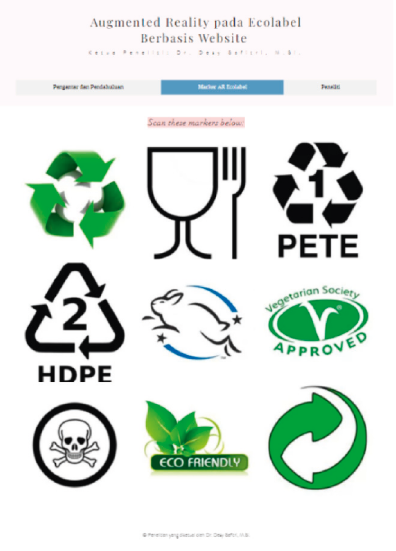
Figure 2: Menu marker